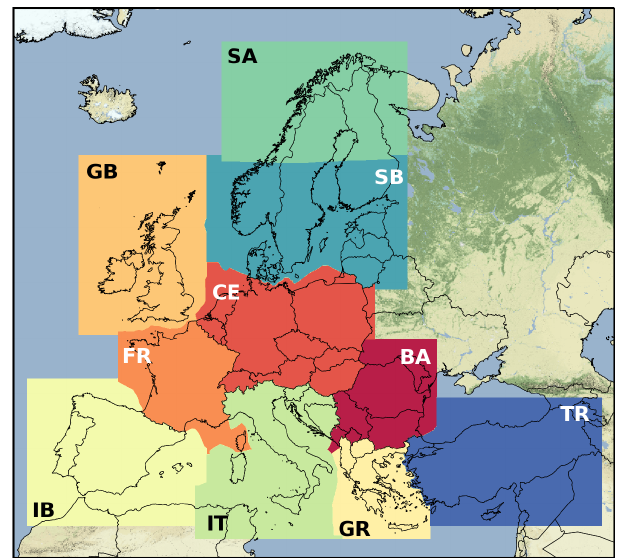
Figure 3. Map showing how the individual mesoscale domains are combined into a single merged dataset. Whenever possible the data for each country’s exclusive economic zone come from the same domain. The background is the stamen terrain background from http://maps.stamen.com/terrain-background (last access: 30